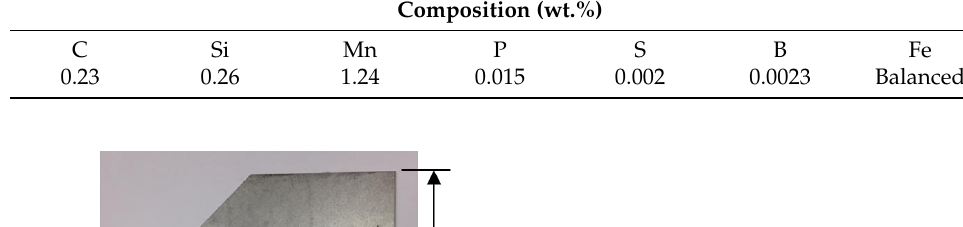
Table 1. Chemical composition of the SABC1470 steel used in the hot stamping test. Composition (wt.%)